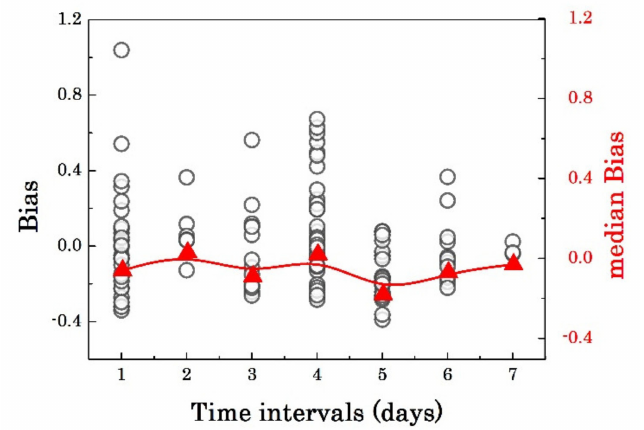
Figure 9. Bias ( black circles ) and median Bias ( red triangles ) between satellite-derived and field SDD results at different time